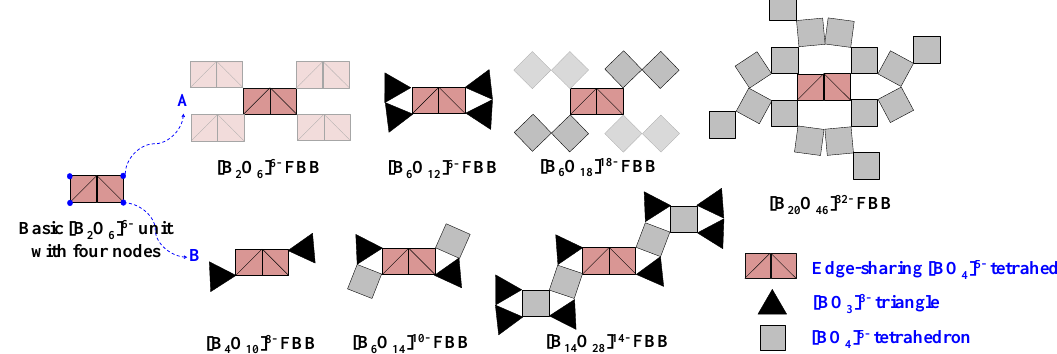
Figure 8. Structural features of all the available anhydrous borates with fundamental building blocks (FBB) containing edge-sharing [BO 4 ] 5 − tetrahedra. Adapted from Ref. [113] with permission from The Royal Society of Chemistry.